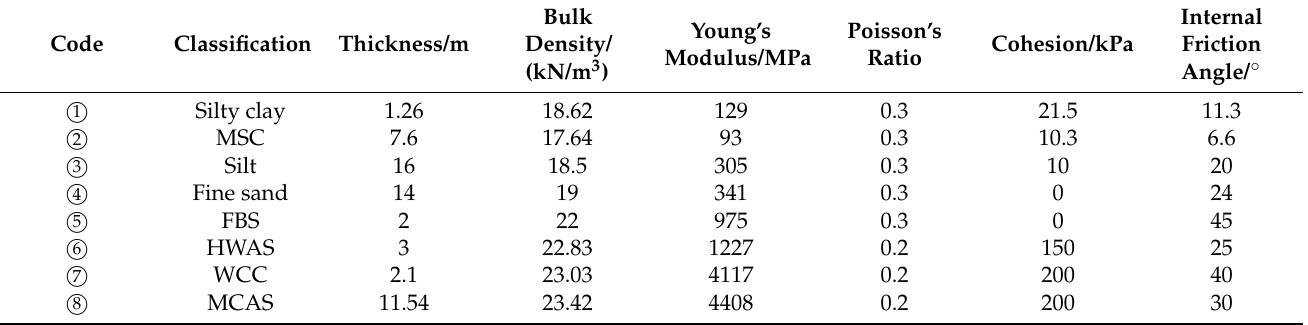
Table 2. Physical and mechanical parameters of the soil around the circular diaphragm